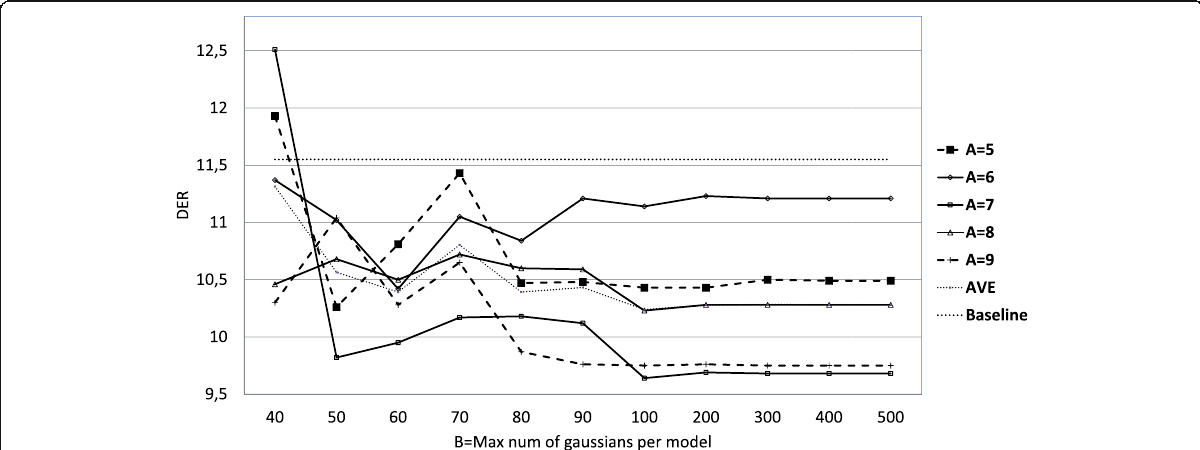
Fig. 11 DER for the DEVELSET versus different values of minimum number of seconds per Gaussian (parameter A) and maximum number of Gaussians (parameter B)